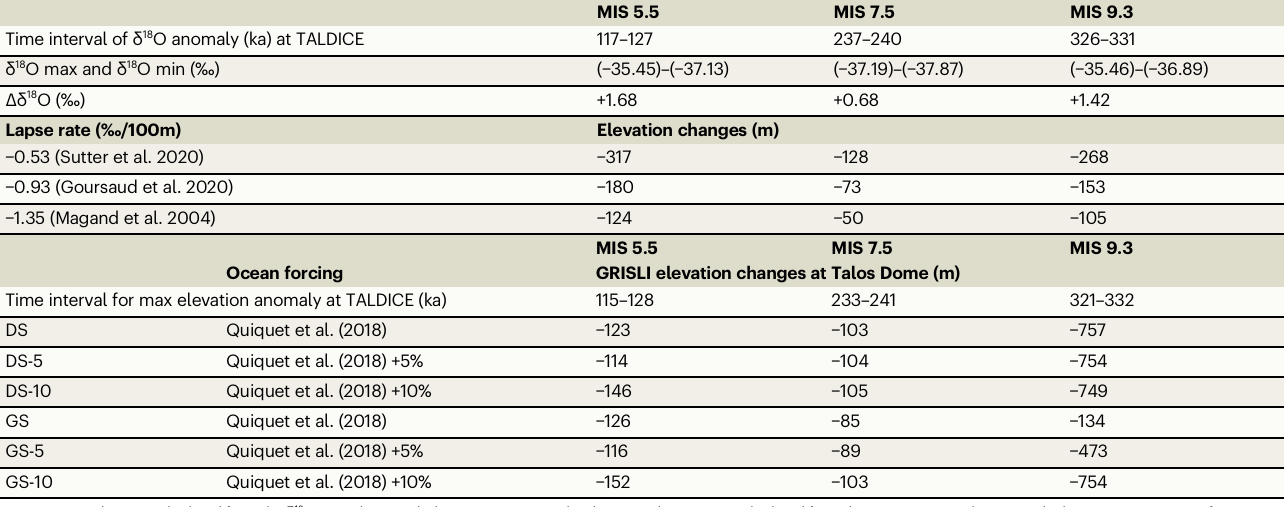
Isotopicanomaliesarecalculatedfromthe δ 18 Orecordresampledat200yearintervals.ElevationchangesarecalculatedfromtheisotopicanomaliesusingthelapserateestimatesofSutteretal. 9 , Goursaudetal. 29 ,andMagandetal. 49 .DeglaciatedStart(DS)andGlacialStart(GS)elevationchangesaremodelledfor6sensitivitytestsperformedwiththeGrenobleIceSheetandLandIce(GRISLI) icesheetmodel,varyingtheAntarcticicesheetinitialconditionsandtheSouthernOcean(SO)temperatureforcing.DSsimulationsareinitializedwithAntarcticinterglacialinitialconditionsat400ka andGSsimulationsareinitializedwithAntarcticglacialinitialconditionsat400ka.ElevationvariationsatTalosDomearecalculatedfortheinterglacialtimeintervalswhenthesimulatedGRISLIice